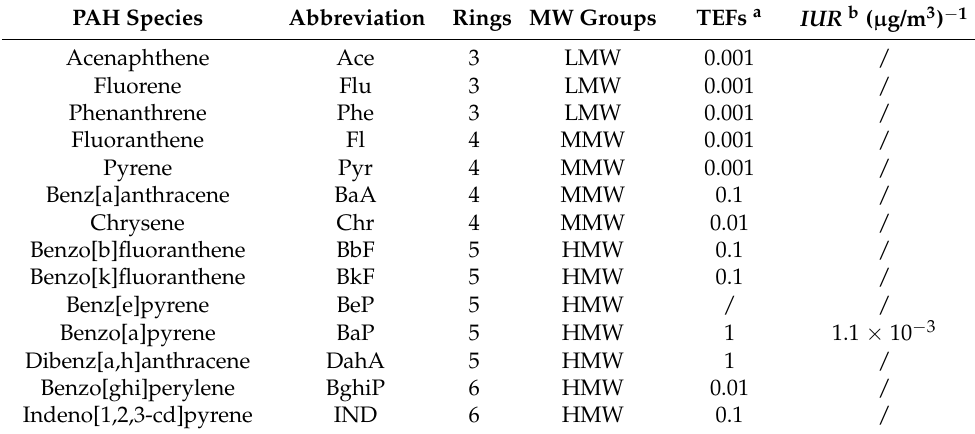
Table 1. Properties of polycyclic aromatic